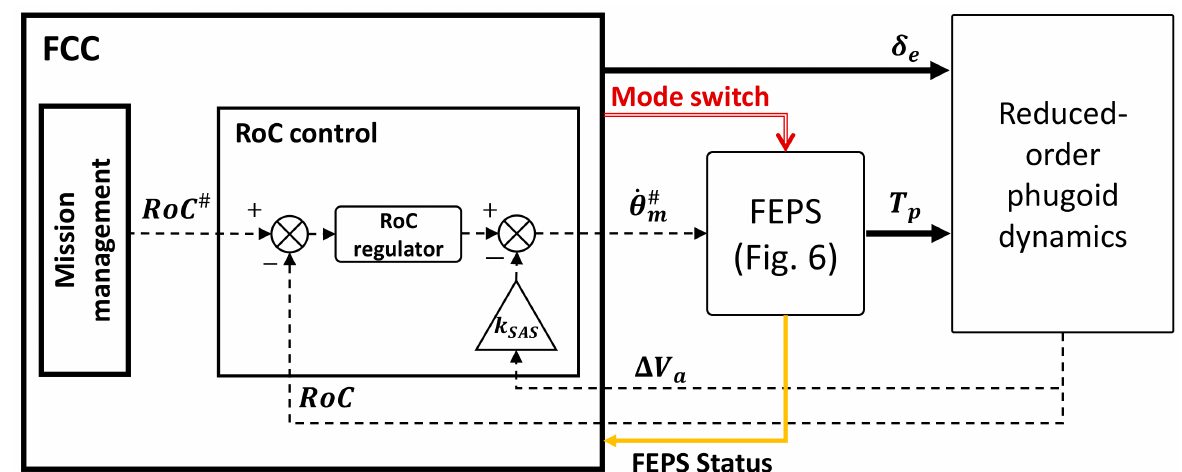
Figure 8. Rate-of-climb closed-loop